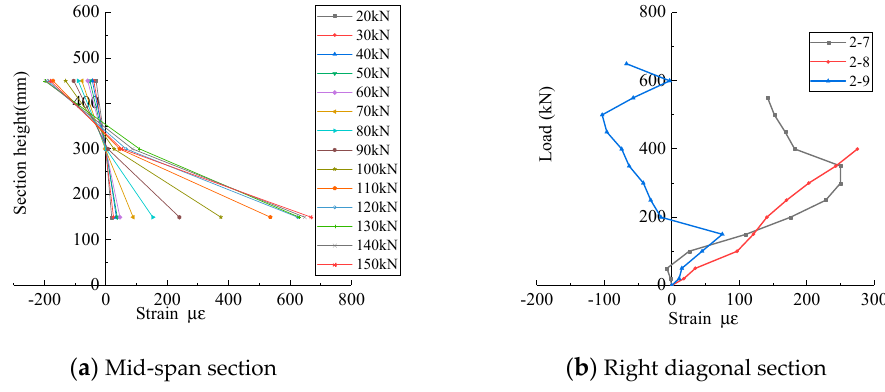
Figure 5. Surface concrete strain of test specimen MDB3.